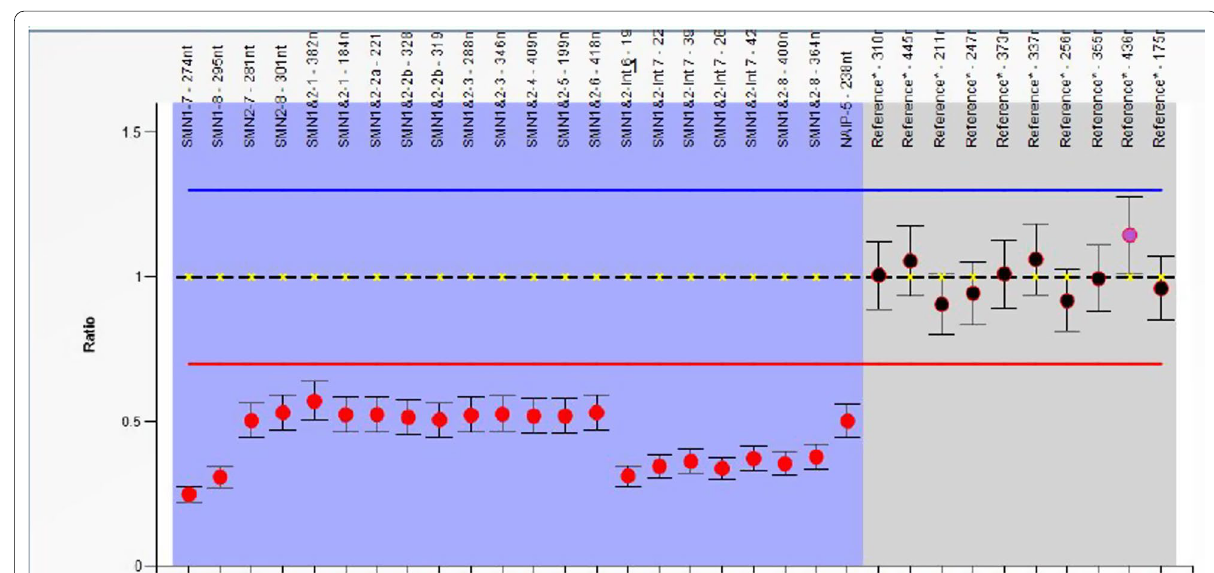
Fig. 2 Analysis of SMA patient with type III showing heterozygous deletion of exons 7 and 8 of SMN1 gene, and expected heterozygous deletion of exons 1–6 of SMN1 gene. A MLPA analysis showing median value of 0.755 for the 10 probes detecting exon 1–6 of both SMN1 and SMN2 genes (3 copies) and median values of exons 7 and 8 of SMN1 gene and SMN2 gene between 0.52–0.63 (1 copy of each). B Expected distributions of SMN1 & SMN2 genes exons showing (a) heterozygous deletion of the whole SMN1 gene from one allele, which doesn’t explain the phenotype, (b) heterozygous deletion of exons 7 & 8 of SMN1 gene from one allele and heterozygous deletion of exons 1–6 from the other allele, which could be pathogenic for SMA., (c &d) heterozygous deletion of exons 1–6 of SMN2